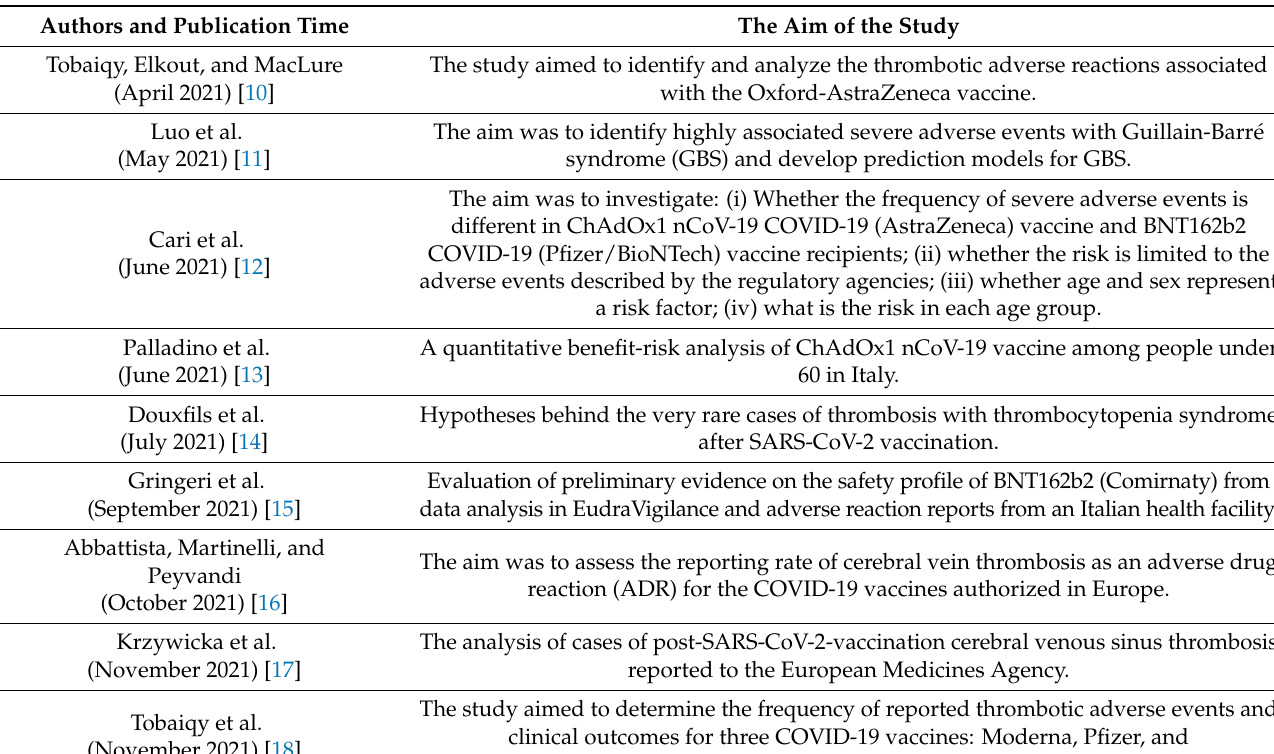
Table 1. Studies selected from the PubMed database that used data on COVID-19 vaccines from the EudraVigilance